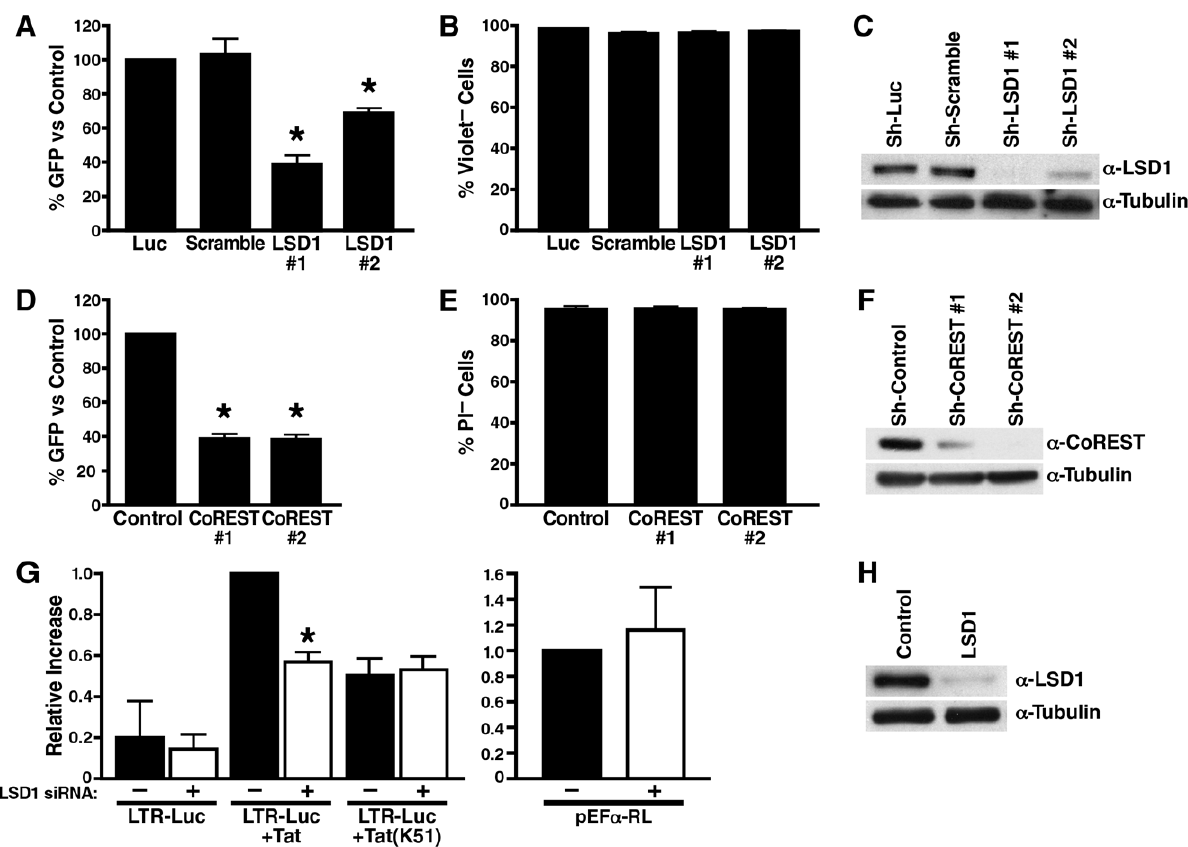
Figure 6. LSD1/KDM1 and CoREST activate HIV transcription. (A) Lentiviral vectors expressing shRNAs against LSD1 ( # 1 and # 2), luciferase or scrambled shRNAs were infected into J-Lat A2 cells for 5–10 days; cells were then stimulated with a low dose of TNF a (0.08 ng/ml) over night. Number of GFP + cells was analyzed by flow cytometry and expressed as percent GFP + cells as compared to luciferase-shRNA-infected A2 cells. The average (mean 6 SEM) of three independent experiments is shown. *corresponds to a p value , 0.01. (B) Number of violet dye-negative cells was measured as a marker of cell viability by flow cytometry in cells described in (A). Of note, propidium iodide (PI) staining could not be performed in these cells because of the mCherry marker expressed by the LSD1 shRNA vector (C) Whole cell lysates from shRNA-expressing cells were analyzed by western blotting using a -LSD1 and a -tubulin antibodies. (D) Lentiviral vectors expressing shRNAs against CoREST ( # 1 and # 2) or control shRNAs were infected into J-Lat A2 cells. The same experiment as in (A) was performed. The average (mean 6 SEM) of three independent experiments is shown. *corresponds to a p value , 0.01. (E) Number of PI-negative cells was measured as a marker of cell viability by flow cytometry in cells described in (D). (F) Whole cell lysates from shRNA-infected A2 cells were analyzed by western blotting using a -CoREST and a -tubulin antibodies. (G) SiRNA-transfected HeLa cells (48 h after siRNA transfection) were re-transfected with an HIV LTR luciferase reporter construct and expression vectors for wildtype or K51A mutant Tat. In parallel, same amounts of EF-1 a RL reporter constructs as used for Tat were transfected to monitor Tat expression. Luciferase or Renilla activities were measured 24 h after plasmid transfections. The relative differences in luciferase activity as compared to wildtype Tat transactivation were calculated. The average (mean 6 SEM) of three independent experiments is shown. *corresponds to a p value , 0.01. (H) Whole cell lysates from siRNA-transfected HeLa cells were analyzed by western blotting using a -LSD1 and a -tubulin antibodies.